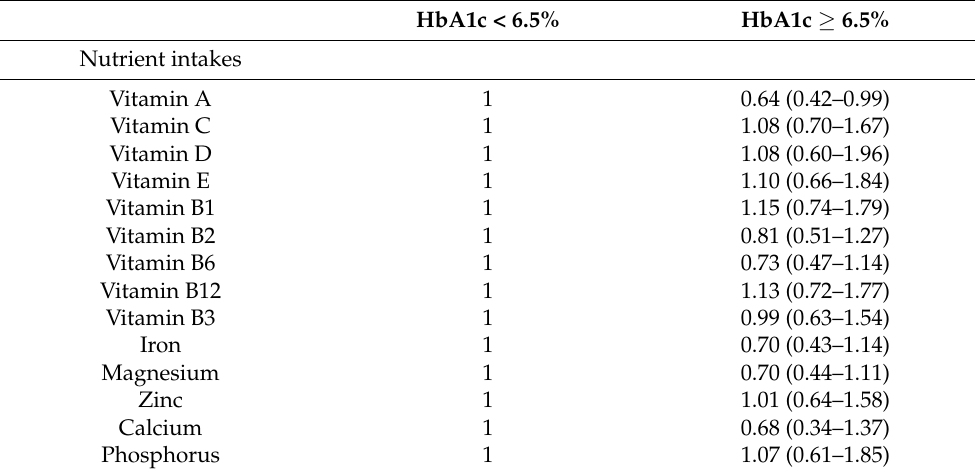
Table 2. The associations between adherence to the DRIs of selected micronutrients and the risk of having type 2 diabetes (men).